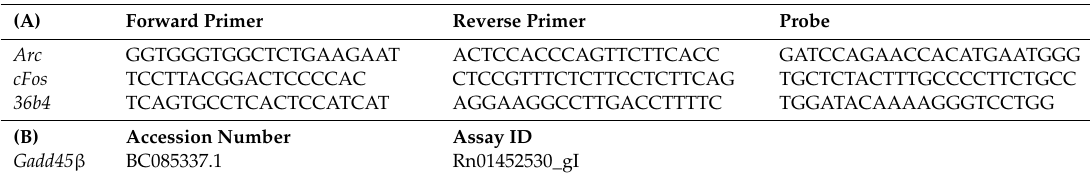
Table 2. A–B: Primers and probes purchased from Eurofins MWG-Operon ( A ) and probes purchased from Life Technologies ( B ).